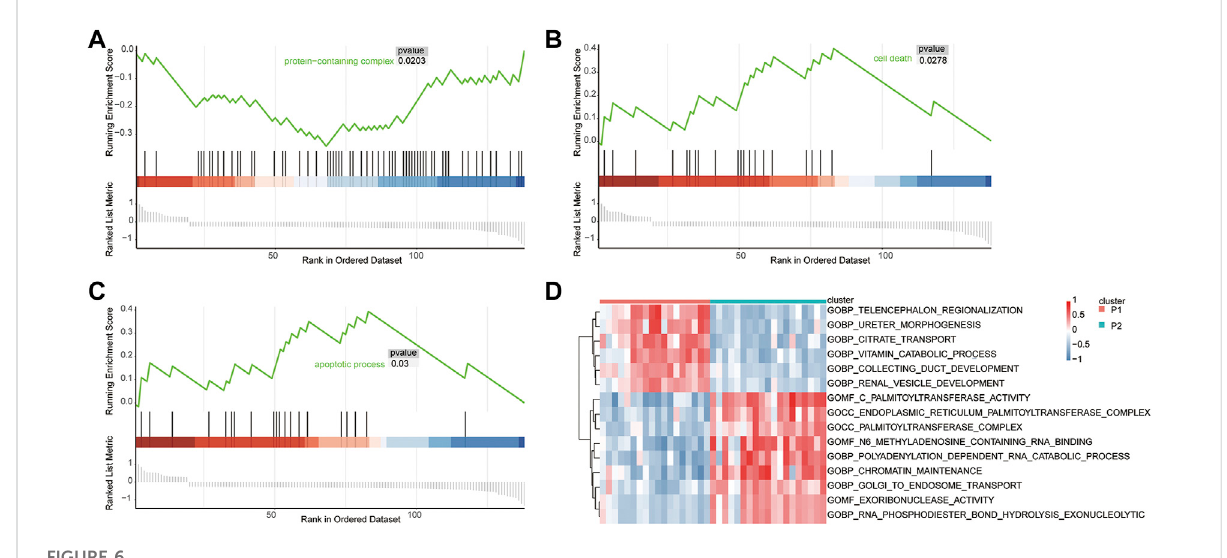
FIGURE 6 GSEA and GSVA. Gene set enrichment analysis demonstrating the protein-containing complex (A) , cell death (B) , and apoptotic process (C) signaling pathways enrichment in T2D. (D) GSVA analysis of differential